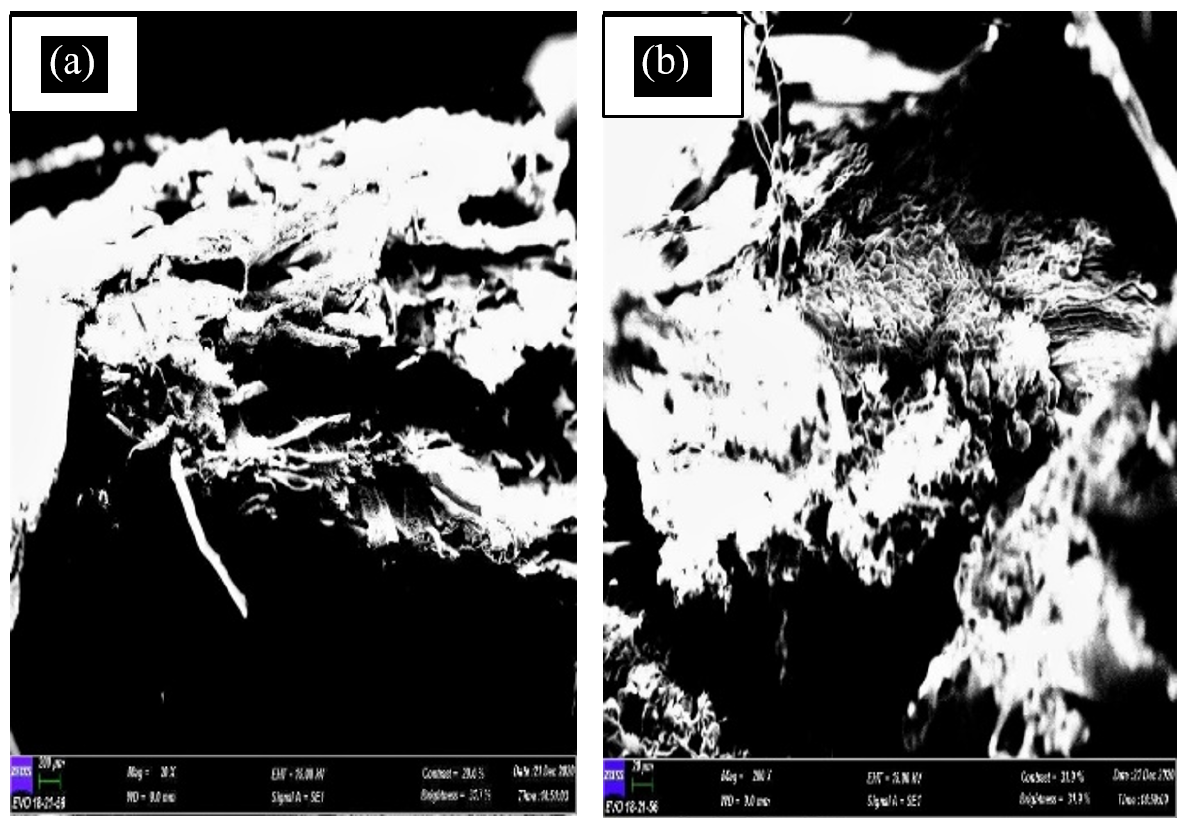
Figure 9. SEM micrograph of pure TPCS ( a , b ).